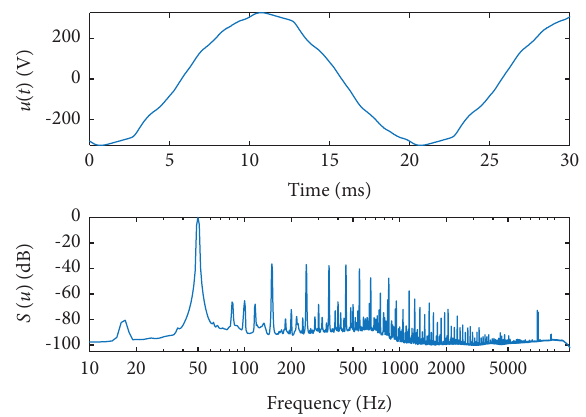
Figure 10: Captured voltage waveform in Stockholm. Top: example of the captured voltage waveform u ( t ) . Data: Stockholm 9 th of May 2019, 20:35. Bottom: power spectrum of one hour of data (Welch estimate, resolution 1Hz, Hann window). Signal-to-noise ratio (SNR) including distortion: 29.6dB. Tis is worst case SNR ob- served for EDR